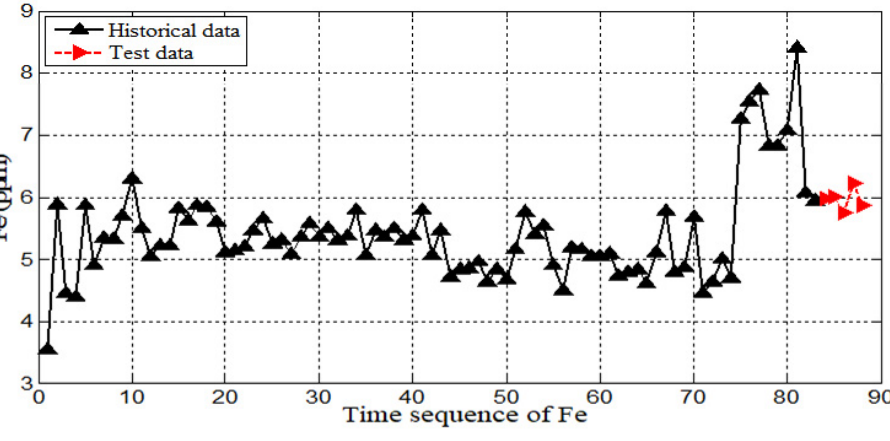
Figure 2. The time sequence of Fe in the